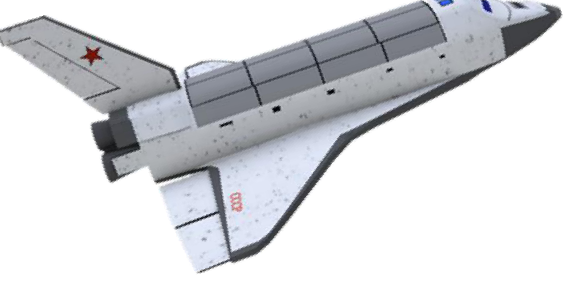
Figure 1. VTHL reusable launch vehicle.